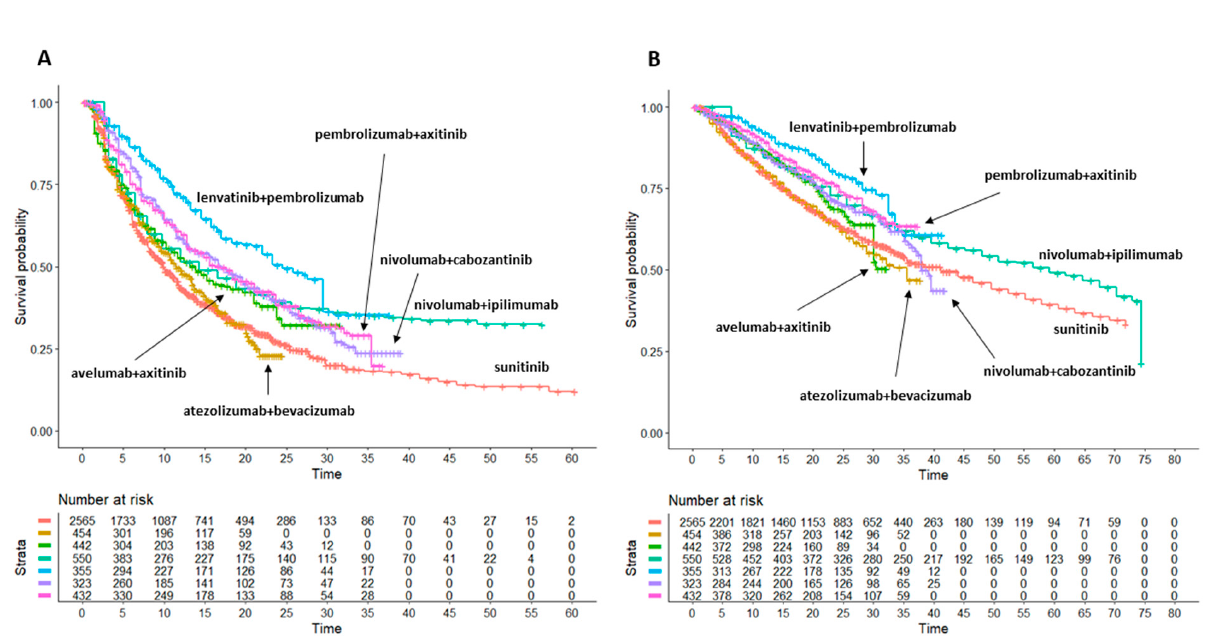
Figure 2. Application of the Shiny method to sunitinib monotherapy ( n = 2565 from 6 trials; in red) and to 6 combination treatments: (a) atezolizumab 1200 mg + bevacizumab 15 mg/kg ( n = 454; in gold); (b) avelumab 10 mg/kg + axitinib 5 mg ( n = 442; in green); (c) nivolumab 3 mg/kg + ipilimumab 1 mg/kg ( n = 550; in light green); (d) lenvatinib 20 mg + pembrolizumab 200 mg ( n = 355; in light blue); (e) nivolumab 240 mg + cabozantinib 40 mg ( n = 323; in purple); (f) and pembrolizumab 200 mg + axitinib 5 mg ( n = 432; in pink); (g) sunitinib monotherapy 50 mg ( n = 2565; in red). n : number of enrolled patients. End-point: ( A ) progression-free survival (PFS), ( B ) Overall survival (OS). Time in months. Table 2. Results of statistical analysis of indirect treatment comparison of PFS between combination regimens.